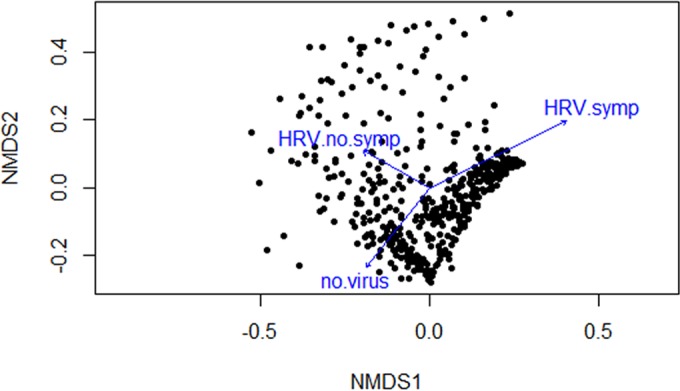
Beta diversity of the microbiota during HRV colonization. Shown is a comparison of the bacterial composition in samples without viral colonization to that in samples with asymptomatic and symptomatic HRV colonization. Weighted beta diversities are represented by using nonmetric multidimensional scaling (NMDS). Arrows indicate clustering of samples without viral colonization (no.virus), HRV colonization without symptoms (HRV.no.symp), and HRV infection with symptoms (HRV.symp). There is a significant difference in beta diversity during symptomatic HRV colonization (“Adonis” function of R; P = 0.04).